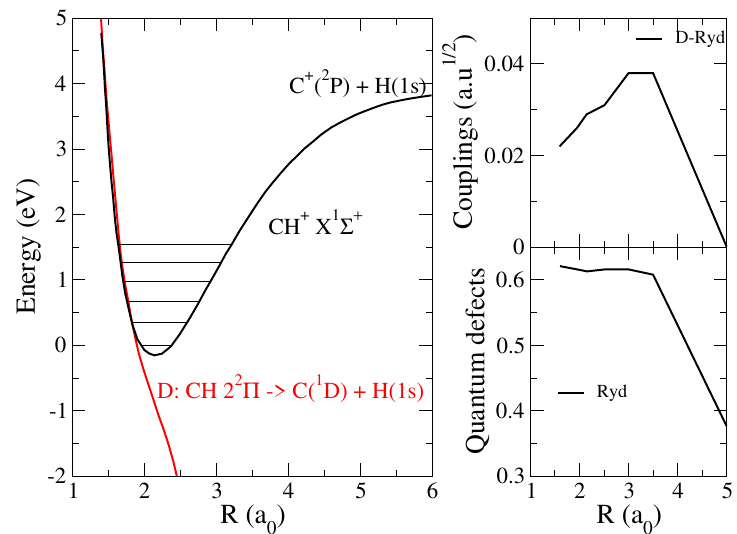
Figure 1. Molecular data sets relevant for the dissociative recombination of CH + compiled from Figures 2–5 of Reference [13]. Left panel: the black line stand for the ground (X 1 Σ + ) electronic state of the ion [25], having the C + ( 2 P) + H(1 s ) dissociation limit, whereas the red continuous (D) line gives the dissociative autoionizing states (2 2 Π ) of the neutral [12]. Upper right panel: electronic couplings: black line between the valence state (D) with the Rydberg states (Ryd) built on the ground ion state. Lower right panel: quantum defects for the Rydberg series based on the ground ion state.